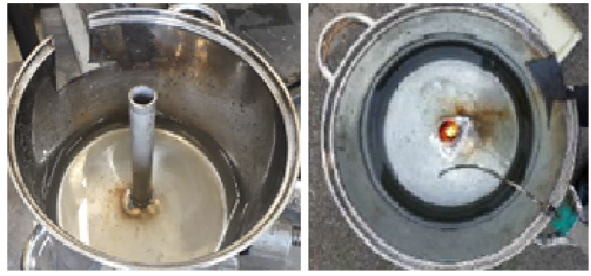
Fig. 2 The pot to be put on the plate or ring and which was perfo- rated by a tube in its center, to periodically inject the pellets in the combustion